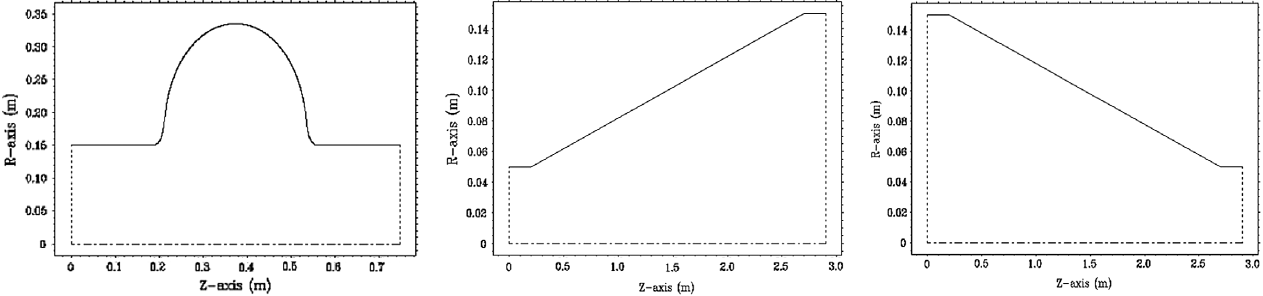
FIG. 14. 400 MHz single cell cavity and tapers used in ABCI .